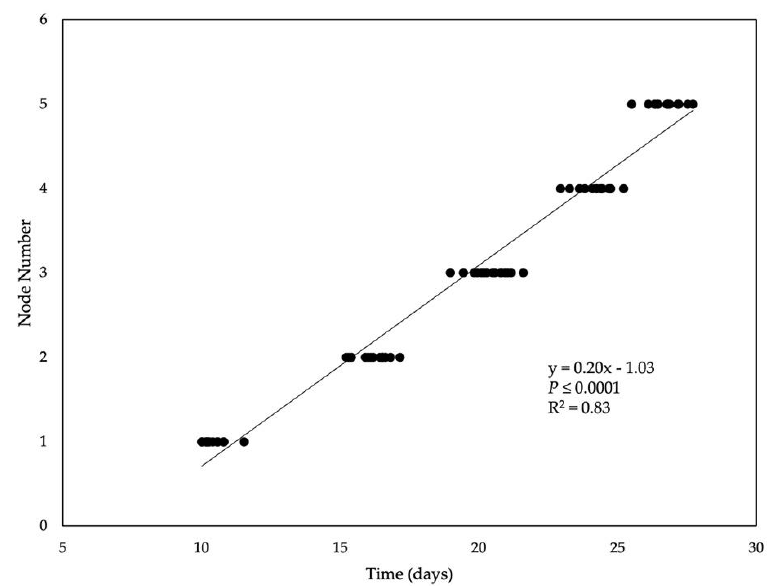
Figure 1. Time from planting (days) to consecutive main stem nodes appearing for soybean cultivars grown under a constant temperature of 25 °C and its corresponding regression equation, coefficient of determination (R 2 ), and p -value.